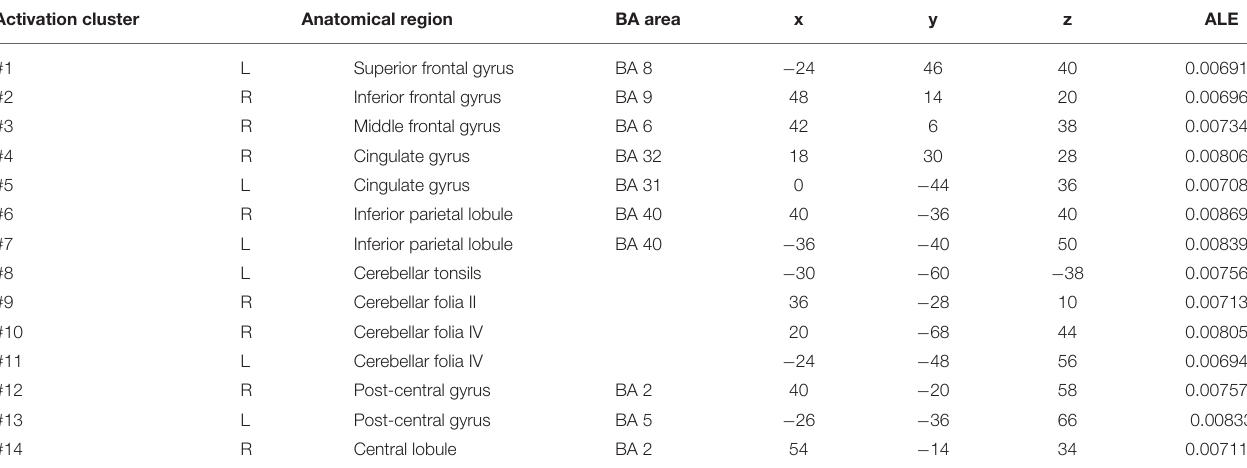
TABLE 4 | Clusters with PD > HC activation in cue-priming